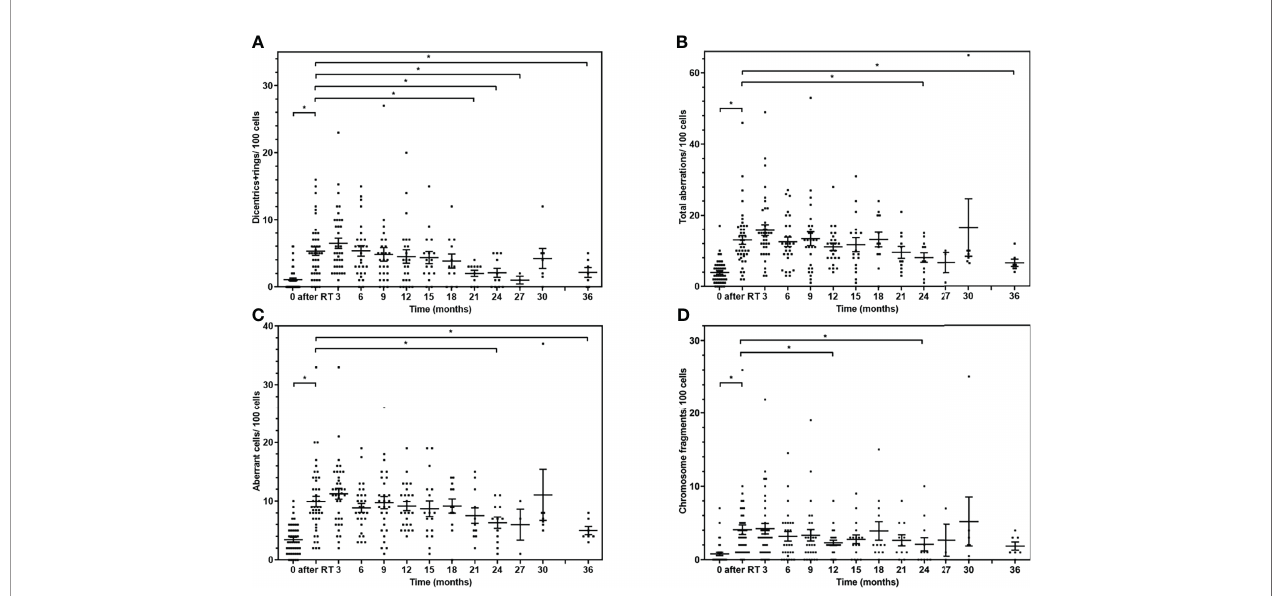
FIGURE 1 | Chromosome aberrations of the lymphocytes of the patients after lung SBRT in follow-up. The individual values and mean (± SE) of chromosome aberrations at different time points. (A) Radiation-speci fi c dicentric-plus-ring chromosome frequency is shown at different time points. (B) The sum of all aberrations in follow-up. (C) The number of cells with any aberration is displayed after radiotherapy. (D) The mean frequency of chromosome fragments due to irradiation. The aberration values are compared with the value directly after radiotherapy with Mann-Whitney U test (* p <